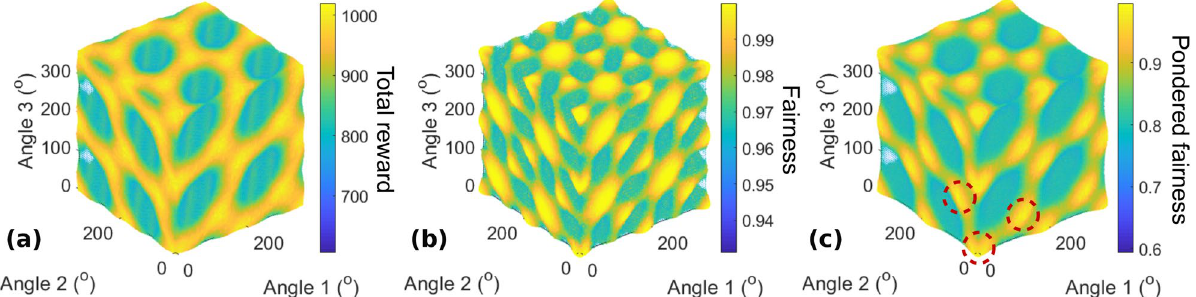
3 users rotating their polarization =